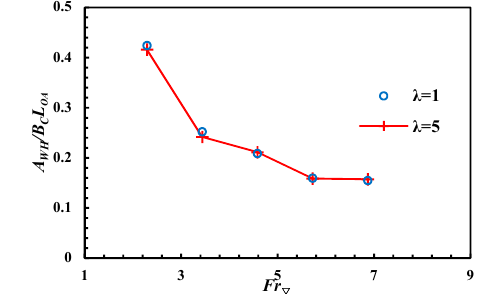
Figure 11. Non-dimensional wetted area.